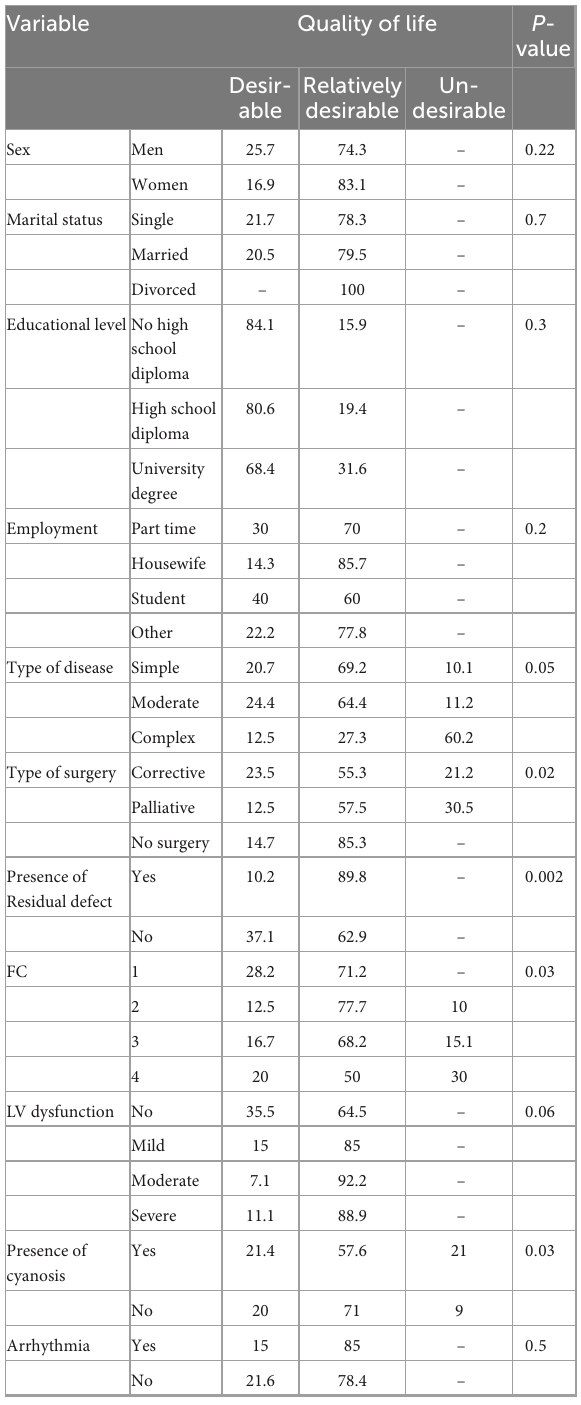
TABLE 2 Relation between patient’s characteristics and quality of life (QoL). Variable Quality of life P -